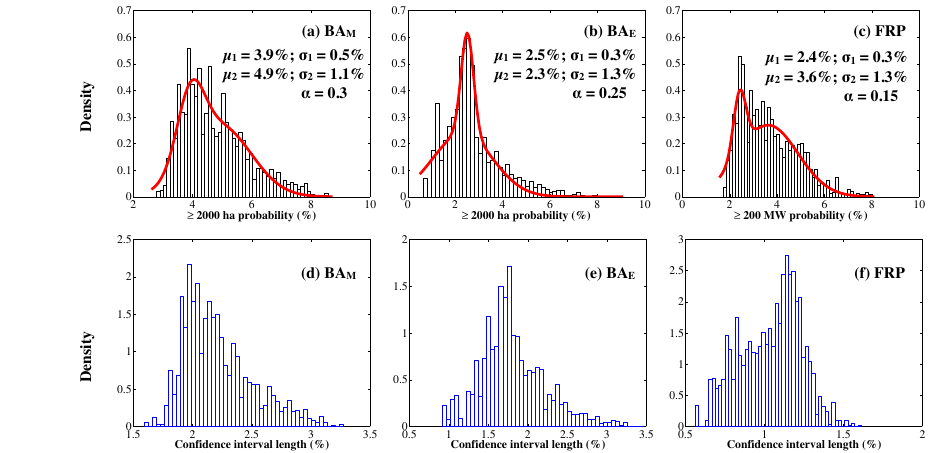
Figure 7. Normalized histograms of the estimated probabilities (black), PDFs of the mixture model (red) and normalized histograms of the 90%-level confidence intervals lengths (blue). (a, d) are for BA M , (b, e) for BA E and (c, f) for FRP. The data set is made of each July–August time period everywhere a fire is detected. The parameters of the gaussian mixture model (Eq. 2) are displayed on each panel of the top